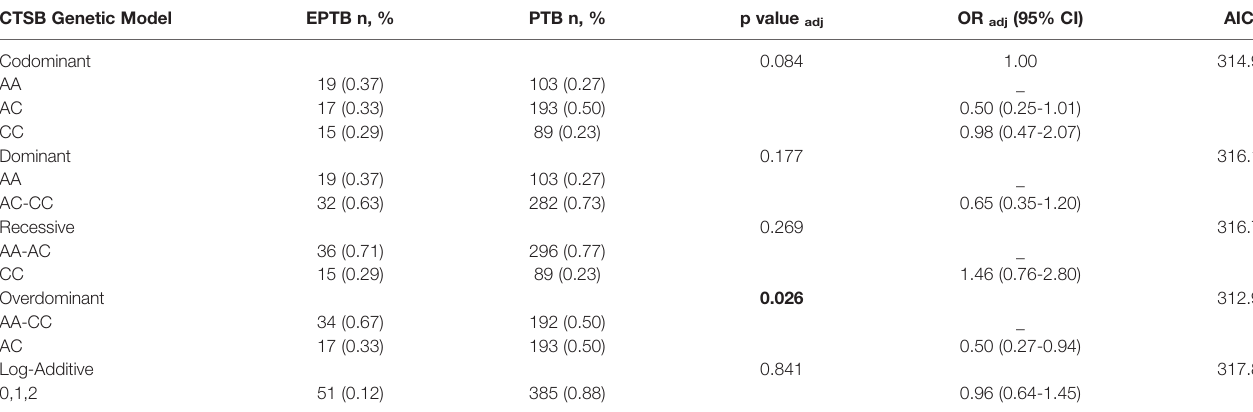
TABLE 4 | Genetic models of association SNV rs1692816 of CTSB gene adjusted for sex and age in patients with extrapulmonary tuberculosis (EPTB) and pulmonary tuberculosis (PTB). CTSB Genetic